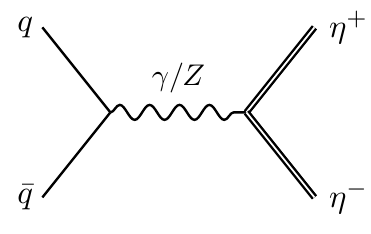
Figure 2 . Co-annihilation partner (CAP) pair-production